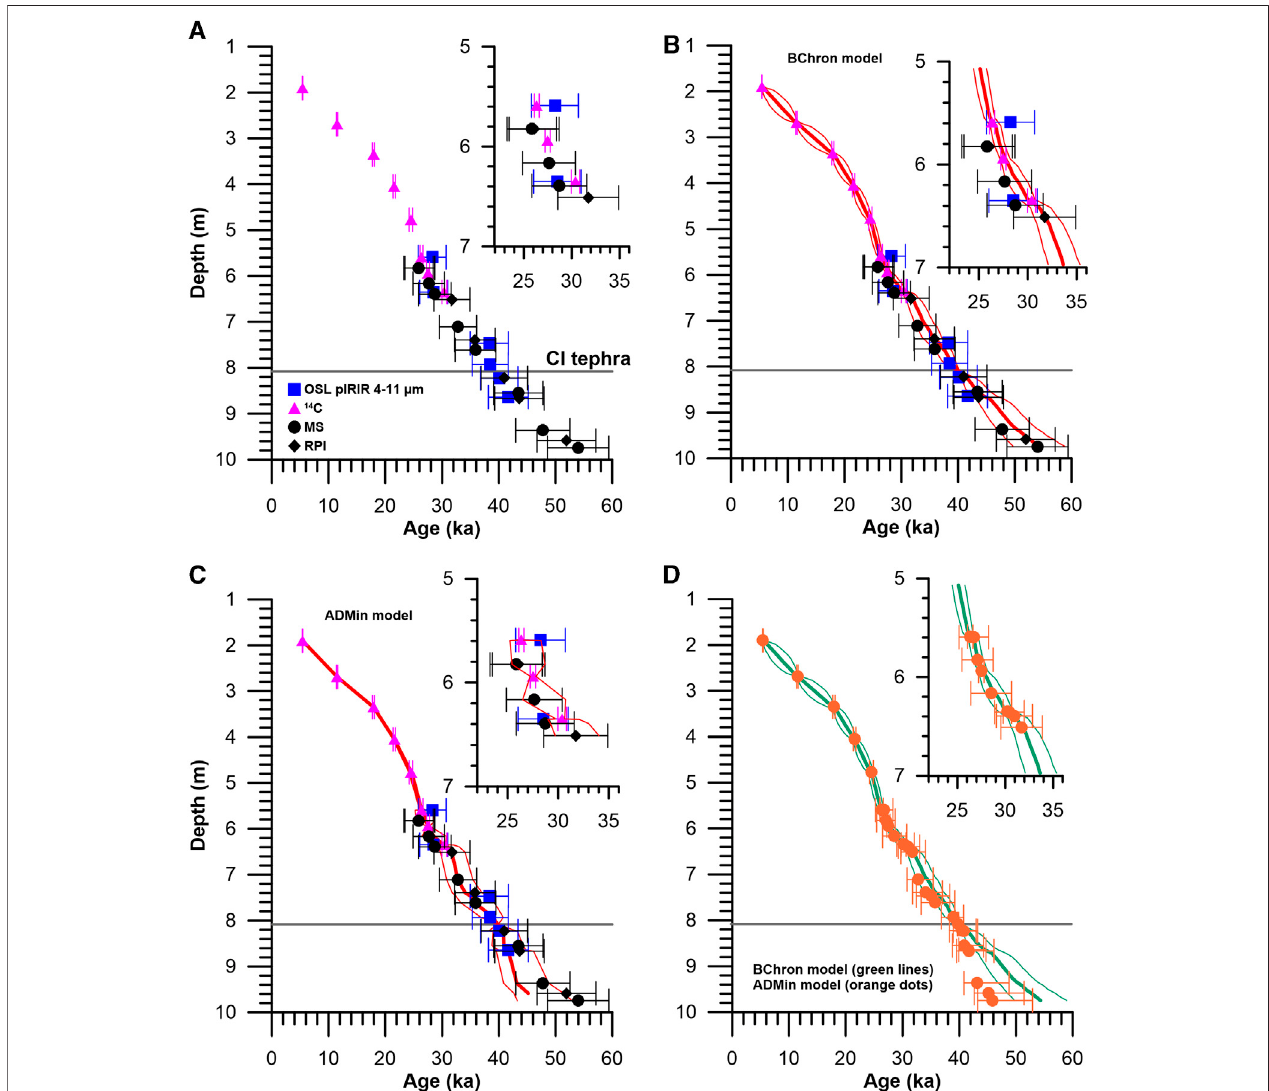
FIGURE 8 | Age models for the BAK pro fi le. The legend is included in (A) . (A) Cross plot of age vs. depth used for modeling, where calibrated 14 C ages and OSL ages (pIRIR 4 – 11 µm) are given as magenta triangles and blue squares, respectively. For several depths (3.35 m, 4.77 m, 6.35 m), all reliable 14 C ages were calibrated andthenaveraged.Agesobtainedbymagneticstratigraphy(black)distinguishbetweenmagneticsusceptibility-baseddata(circles)andRPIbaseddata(diamonds). (B) The result of the BChron model including a 95% con fi dence interval. (C) The results of the ADMin model including a 95% con fi dence interval. (D) Comparison of results from the ADMin (orange) and Bchron (green) models. The uncertainty range of the BChron model is shown as green circles to facilitate comparison. Note that these are in very good agreement in the upper part, but deviate below ∼ 5.5 m depth. For clarity, the insets show a close-up of the data around 6 m depth.